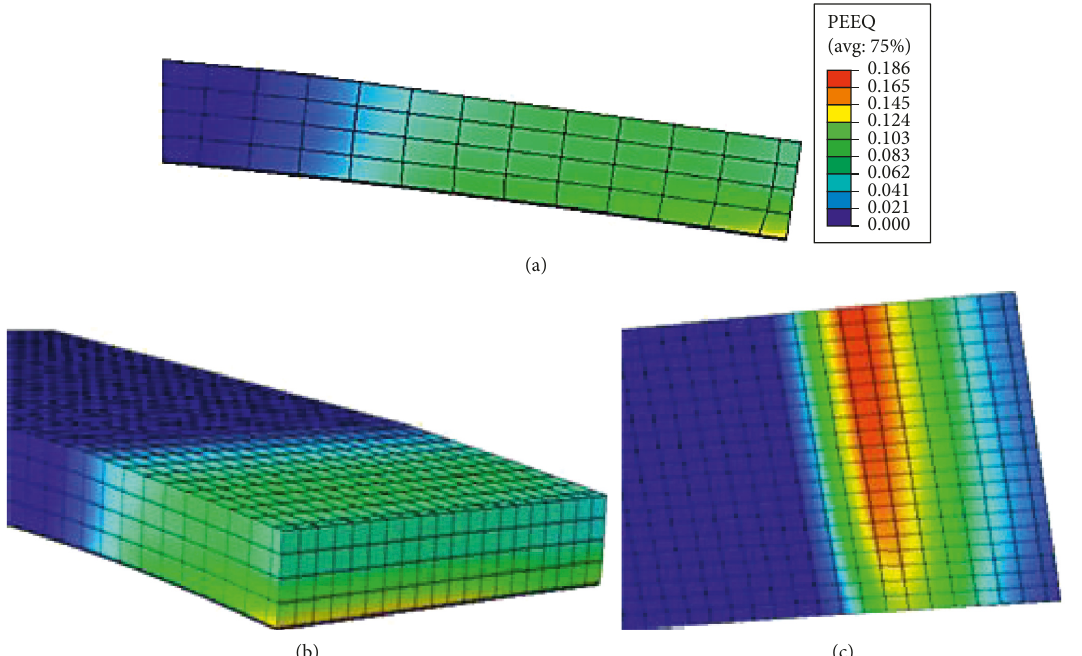
Figure 9: The distribution of equivalent deformations in the thermodeformation hearth (a, b) and in the zone of contact of the tape with the surface of the part (c) with the electrocontact surfacing of the steel tape at K v